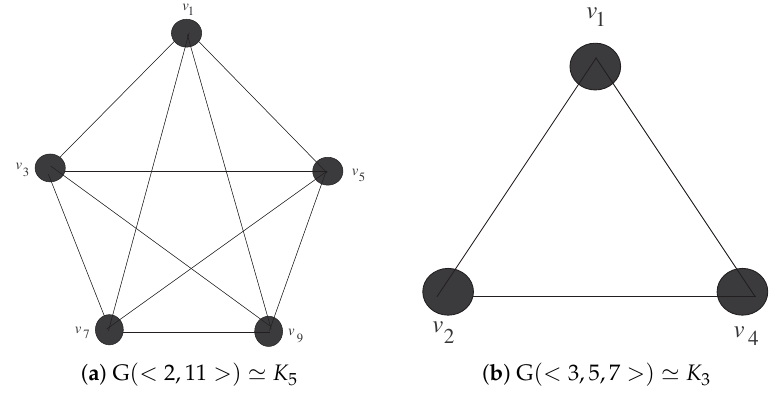
Figure 1. Two examples, when G ( Γ ) is